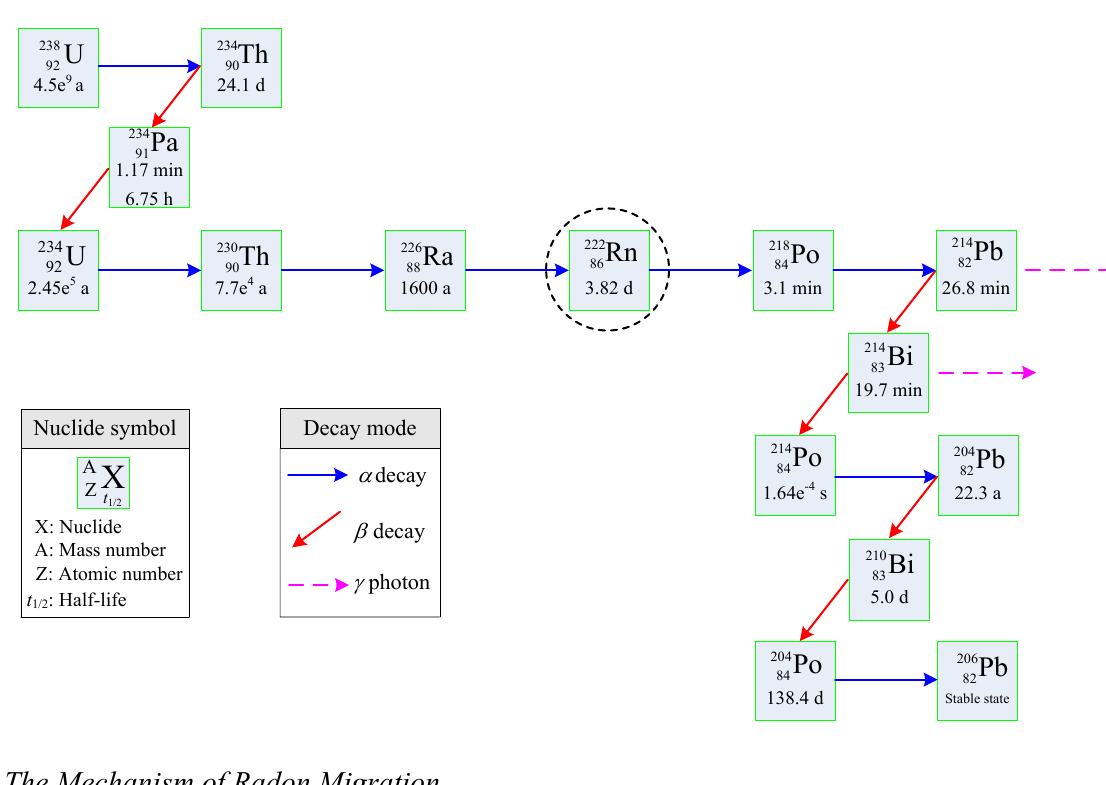
Figure 20. Decay process of the natural 238 U decay